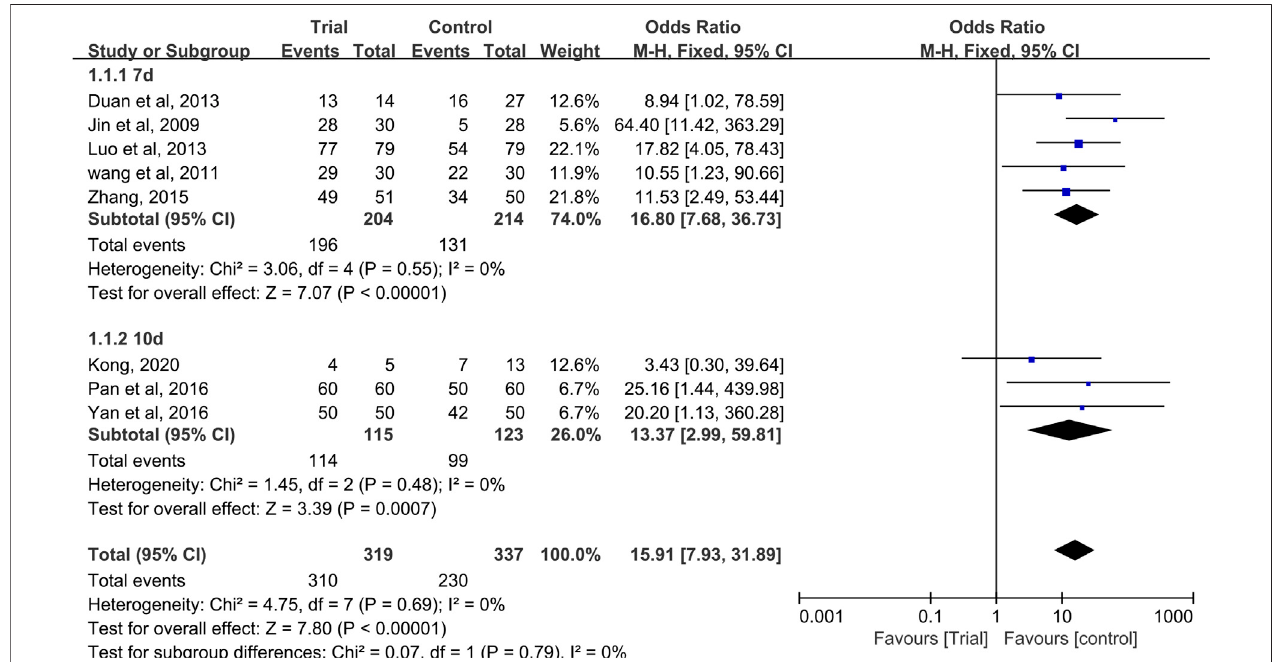
FIGURE 6 | Forest plots of effective rate of CIOM including subgroup analysis based on the course of treatment.